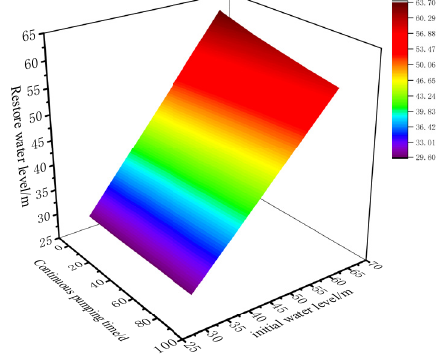
Figure 6. Water level recovery.